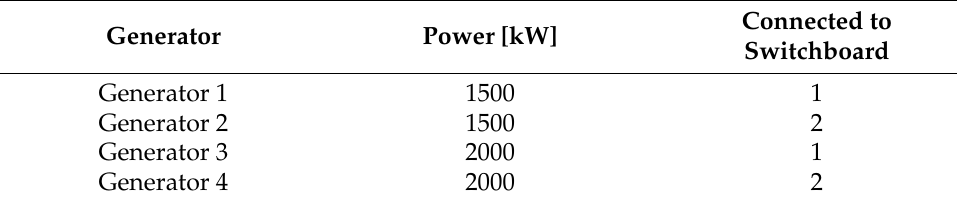
Table 3. Generators powering the ship with conventional positioning system.